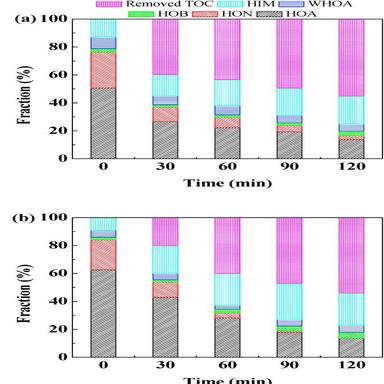
Changes in the size distribution of DOM in raw (a) and bio-treated (b) leachate during oxidation.